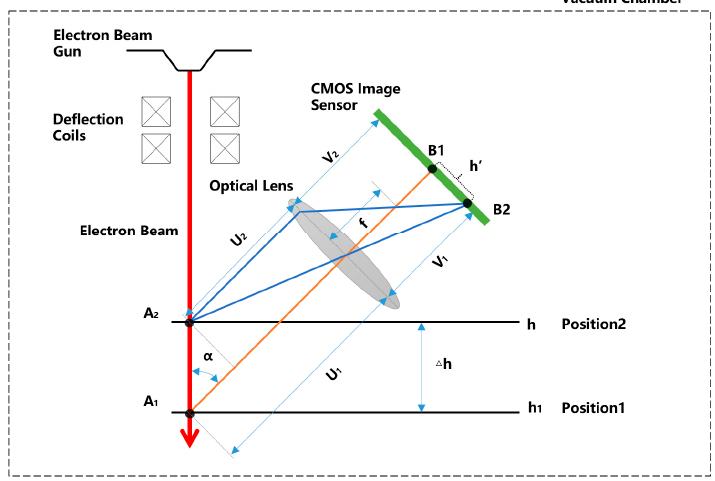
Figure 1. Schematic diagram of online measurement method for deposit surface in electron beam freeform fabrication